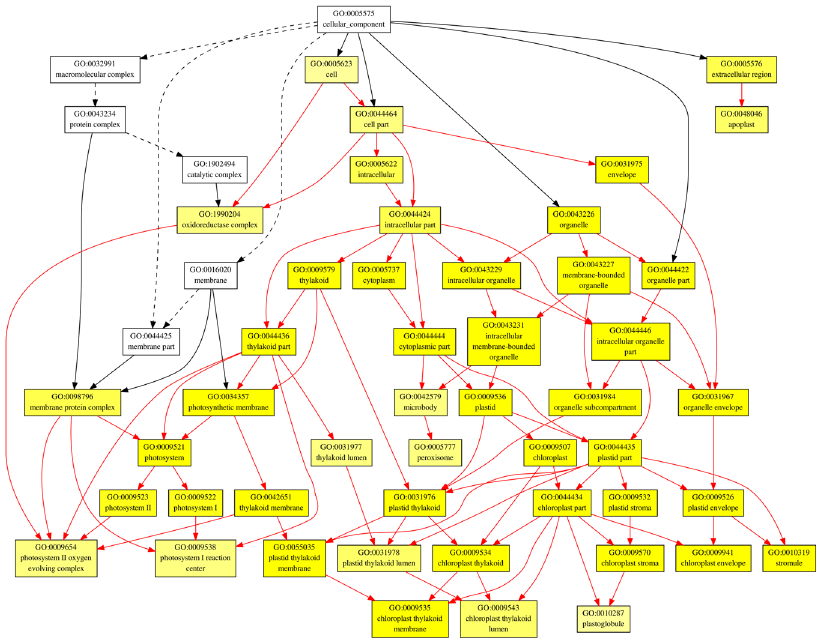
Figure 7. Cellular Component (CC) of GO term enrichment for down-regulated common DEGs in A. stolonifera . Yellow color indicates significantly enriched GO terms. The density of color in each node was proportional to statistical significance of enrichment of the corresponding GO term. Red edges stand for relationship between enriched GO